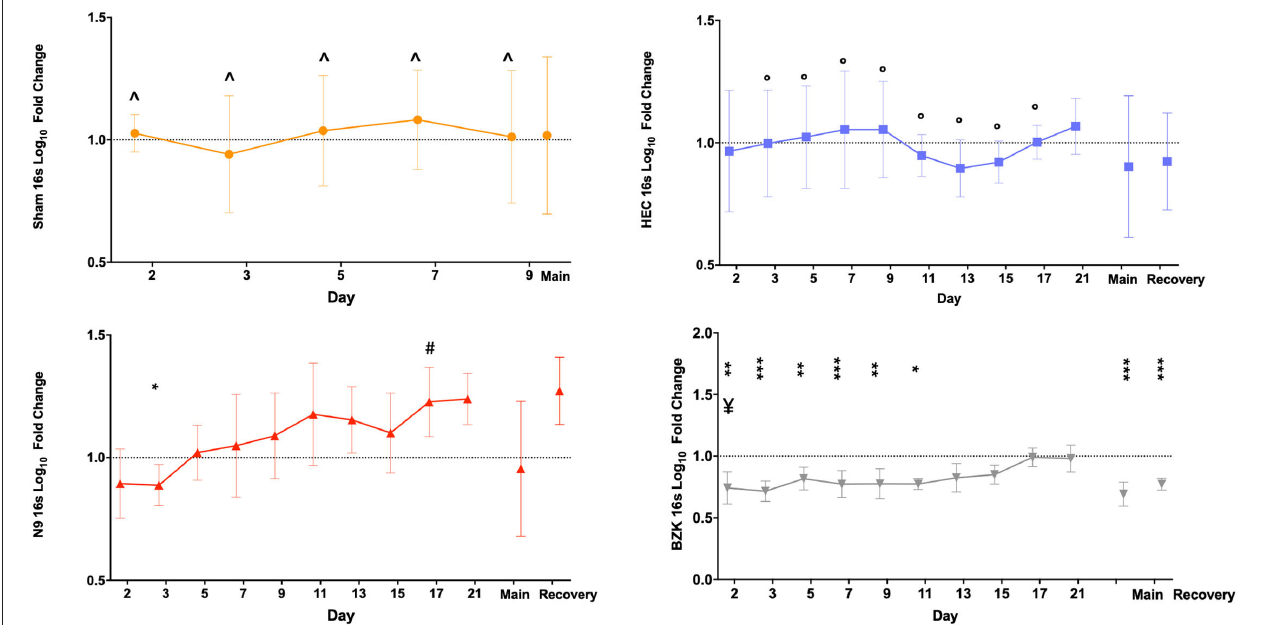
FIGURE 3 | Average log 10 fold change from baseline levels of vaginal bacteria genome counts(16S). Similar analyses were completed on the same swab samples to determine the impact of Sham (top left), HEC placebo gel (top right), N9 gel (lower left), or BZK solution (lower right) applied as described for shGAPDH evaluations. Each plotted point is the averaged fold change with standard deviations. The maximal difference from baseline for the main and recovery periods are again shown as individual values on the right side of each graph for the three treatment groups where recovery period samples were collected. Comparisons were as described for the shGAPDH analyses in Figure 2 . Statistical differences from group baselines are shown as * = p < 0.05; ** = p < 0.01; *** = p < 0.0001 and are more fully described in the results. Pairwise differences between groups were adjusted (Tukey’s or Dunnett’s test) for multiple comparisons, and p < 0.05 findings are indicated with the following comparisons showing statistically significant differences: BZK vs. Sham for D2, 3, 5, 7, and 9; BZK vs. HEC for D5, 7, 9, 11, 13, 15, and 17; BZK vs. N9 for D2; N9 vs. HEC for D17. Non-transformed average daily values are presented in Supplementary Figure 1